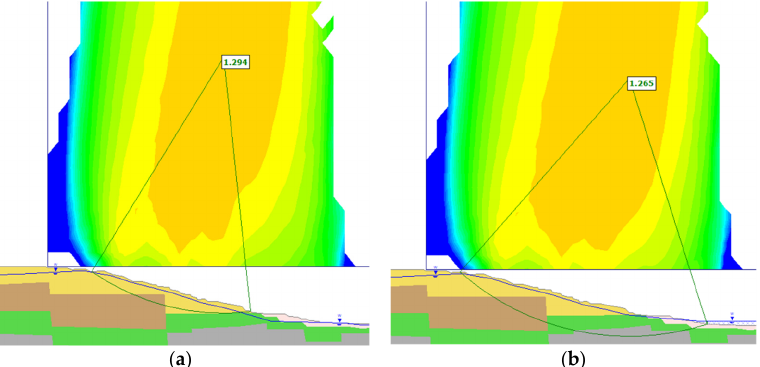
Figure 12. Stability analysis of Section A. ( a ) End of exploitation, with lake level at the base of the pit (+390). Safety factor FS o = 1.294. ( b ) Minimum safety factor FS = 1.265 when the water depth inside the pit is Hw = 20 m (level +410). The initial safety factor (FS o ) is reduced by 2.2%.